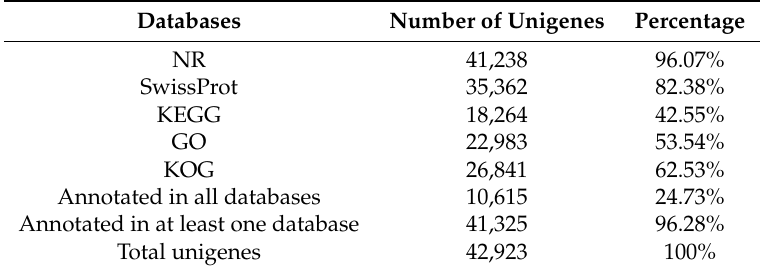
Table 1. The number and percentage of annotated unigenes against five